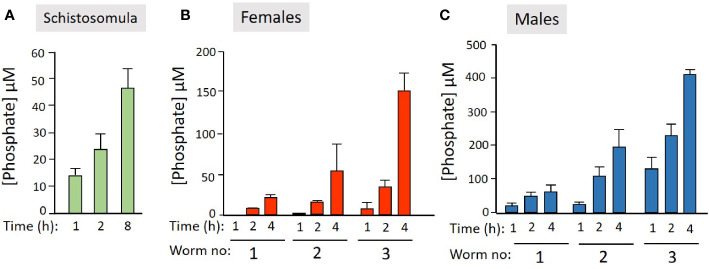
Live schistosome parasites hydrolyze PLP. Phosphate generation (µM, mean +/-SD) by live schistosomula (groups of 2,000, green bars, n = 4, A) or adult females (red bars, n = 5, B) or adult males (blue bars, n = 5, C) in the presence of pyridoxal phosphate (PLP) at the indicated time points. Adult worms were either incubated singly or in groups of two or three, as indicated.